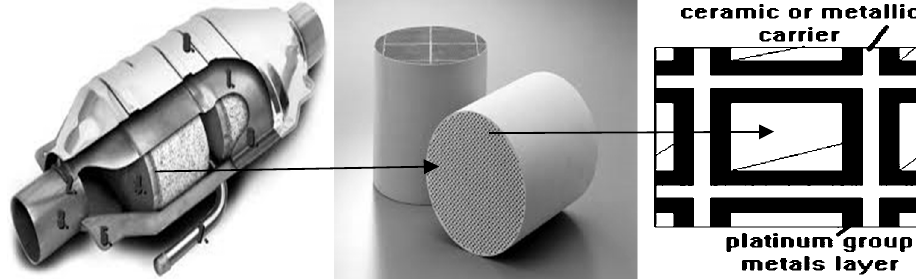
Fig. 1. Carrier auto catalytic converter with the honeycomb structure [8].